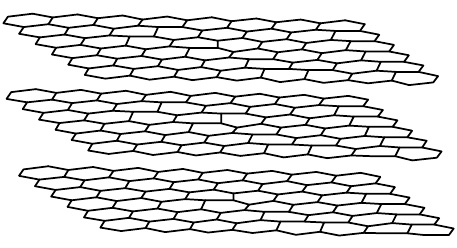
Figure 3. Structure of graphite